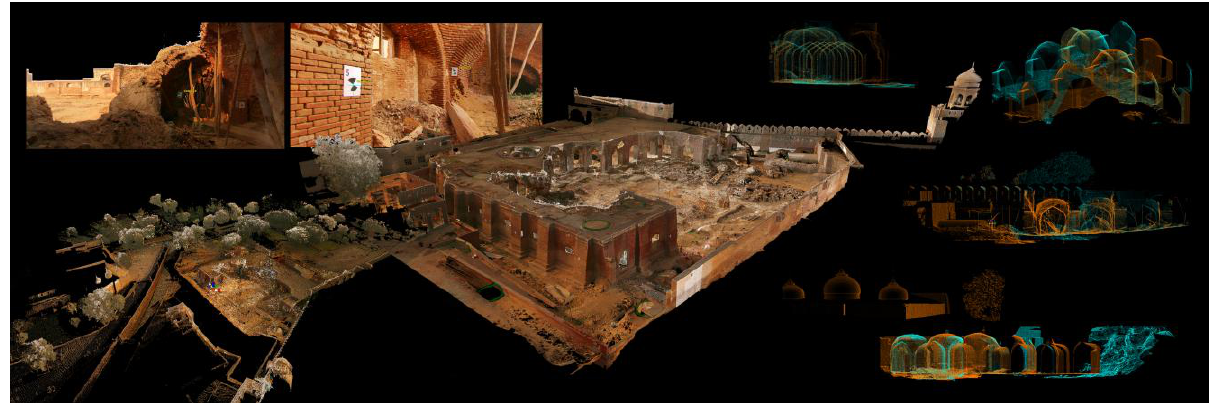
Figure 13. Royal Kitchens 3D laser scanning output and